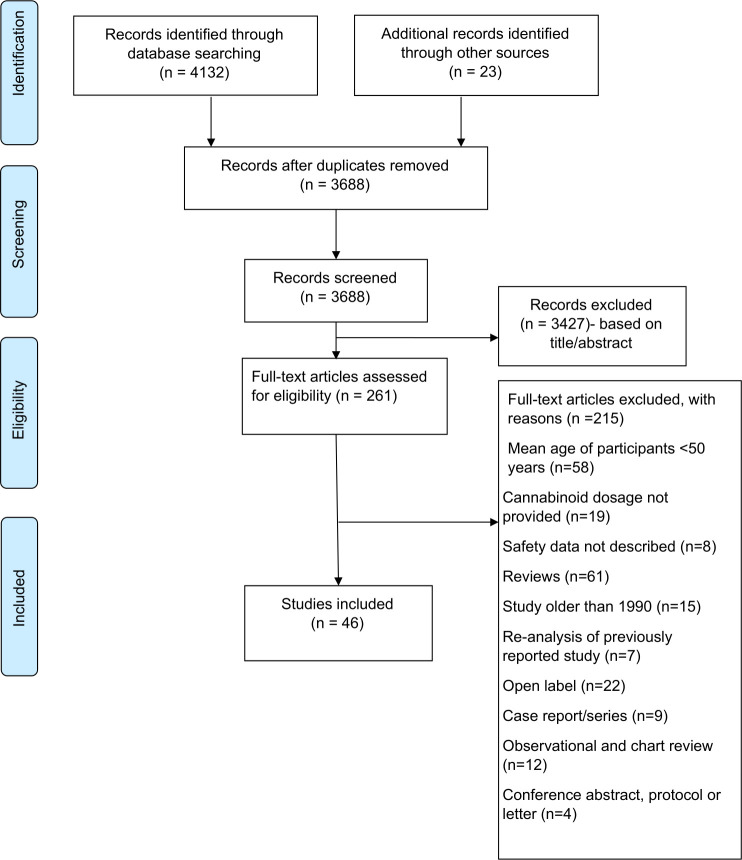
Study disposition.